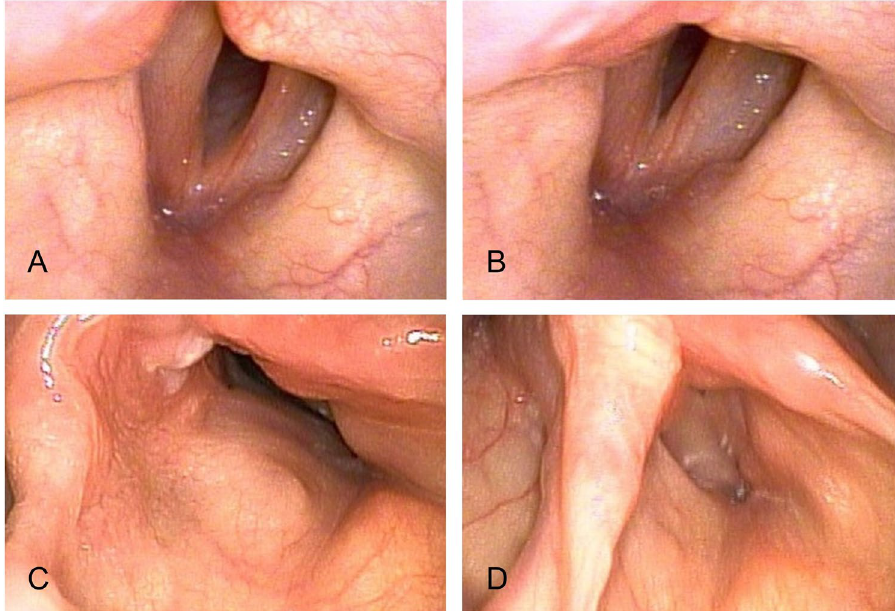
Figure 3. Endoscopic view of the larynx in a 40-year-old man with left vocal paralysis before ( A , inhalation; ( B ) phonation) and after ( C , inhalation; D , phonation) laryngoplasty with thyroid cartilage implantation. The glottal closure markedly improved.